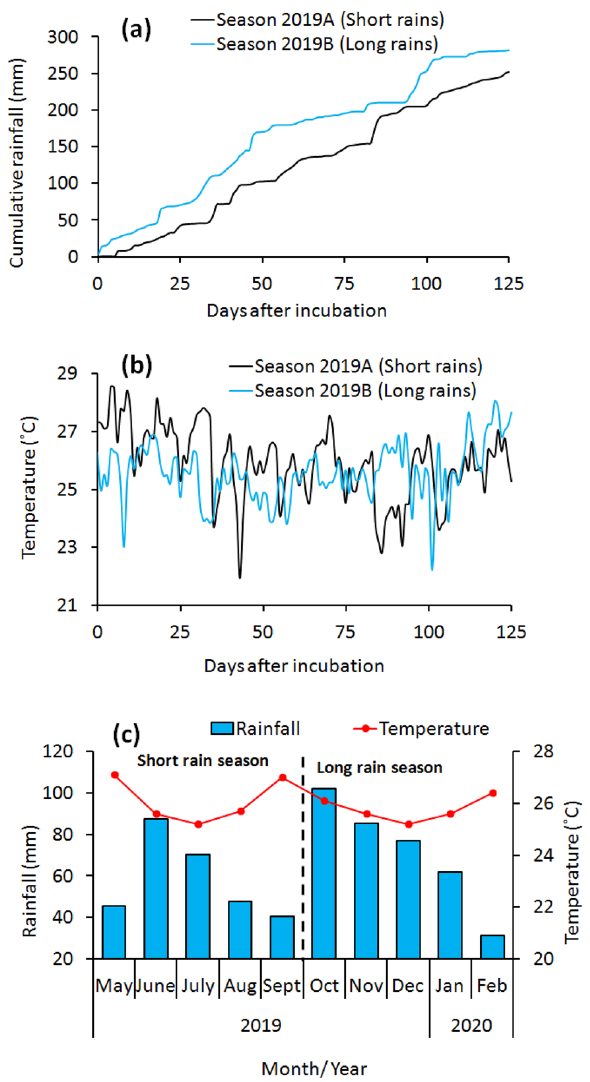
Figure 3. Cumulative rainfall ( a ), daily temperature ( b ) and monthly rainfall and temperature ( c ) during